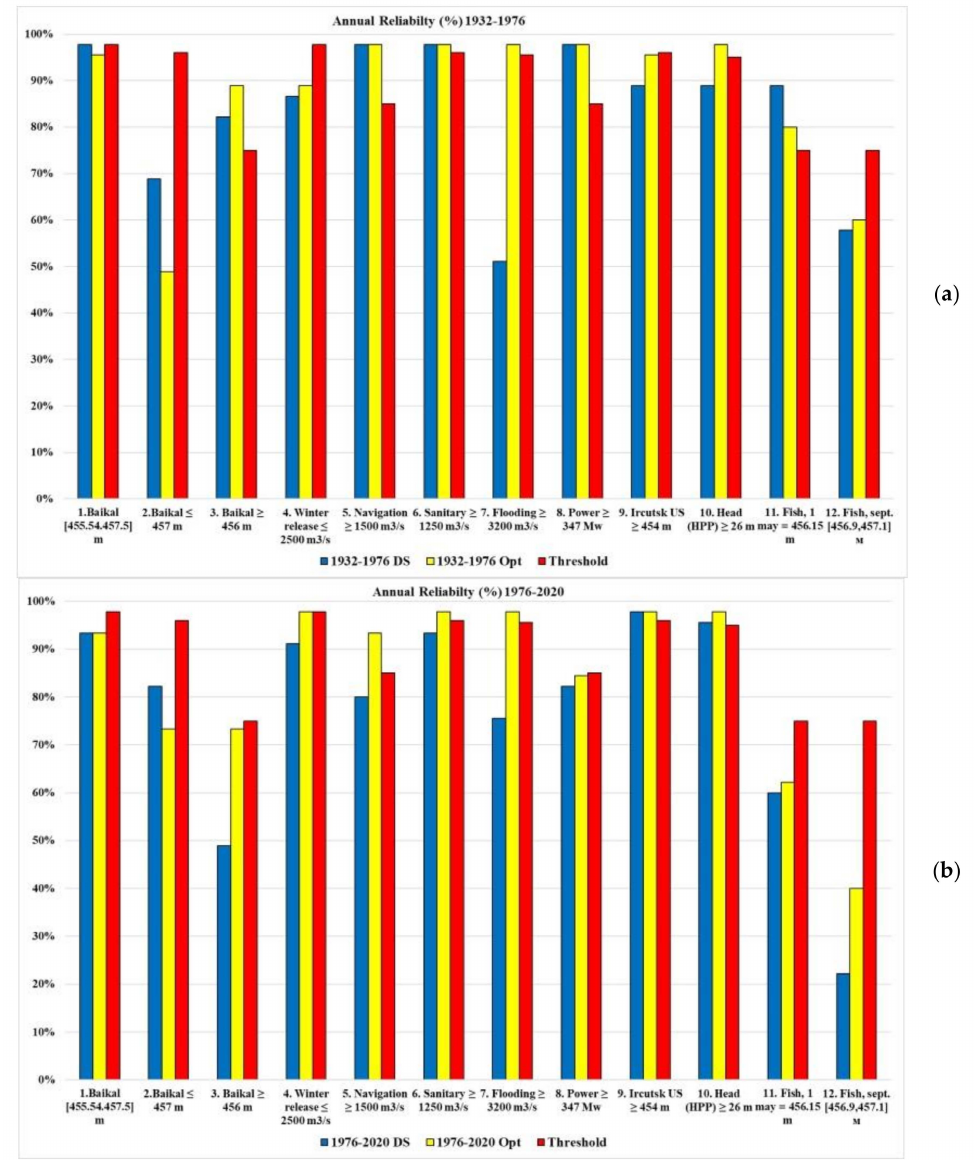
Figure 17. Annual reliability indicators when WRC use DS and optimization ( a ) series 1932–1976 ( b )